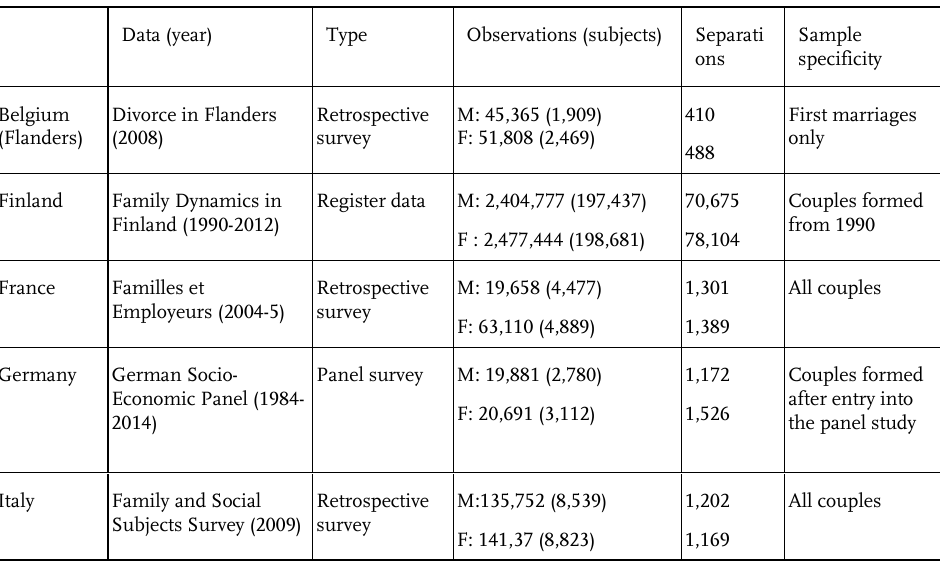
Table 1 : Description of data